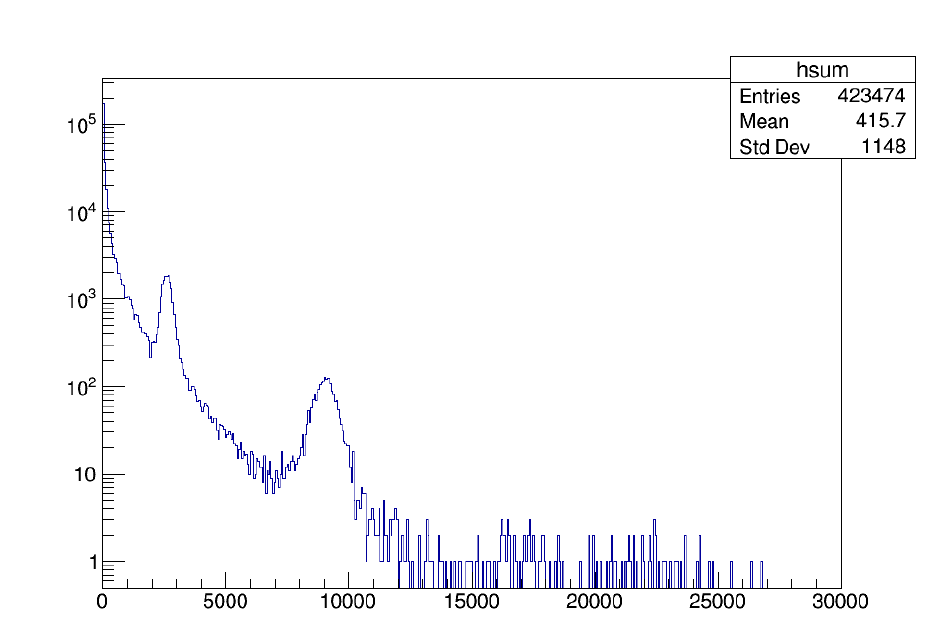
Figure 3. Photon spectra, sum of calibrated